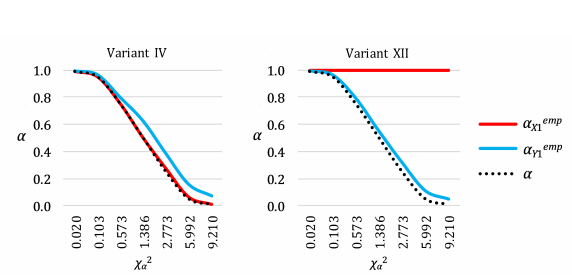
Fig. 2. Empirical significance levels for HLWEs in horizontal